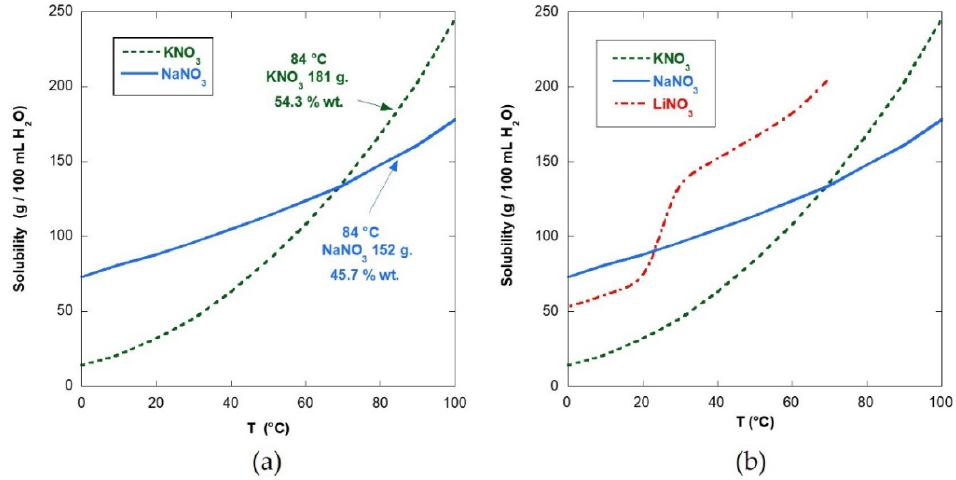
Figure 1. Solubility curves in water, at varying temperatures, of ( a ) KNO3 and NaNO3 and ( b ) LiNO3 compared to the other two salts.